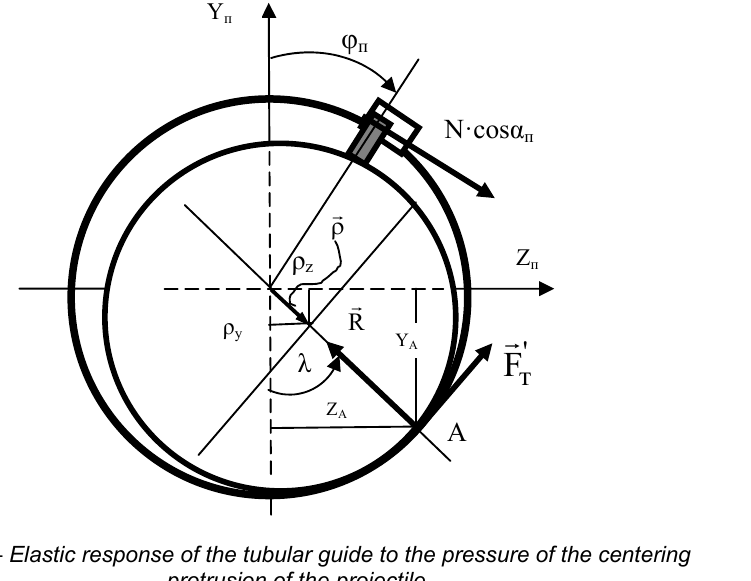
Figure 5 – Elastic response of the tubular guide to the pressure of the centering protrusion of the